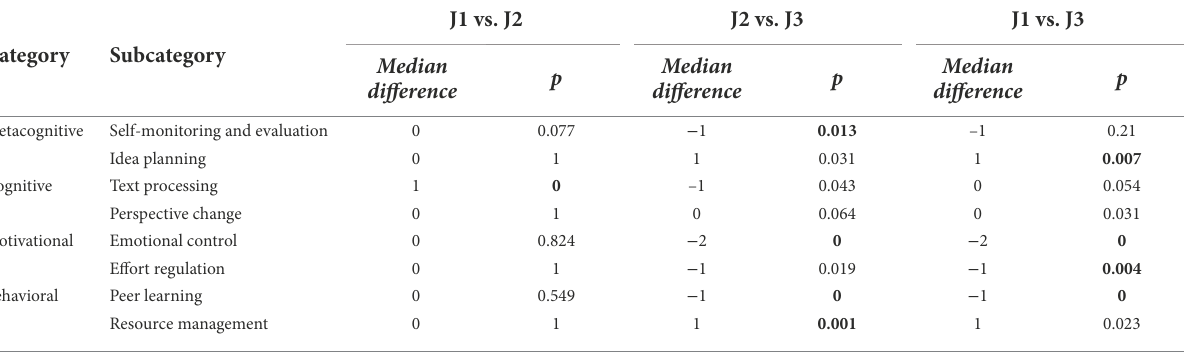
Adjustment for multiple comparisons: Bonferroni. The bold values are statistically significant